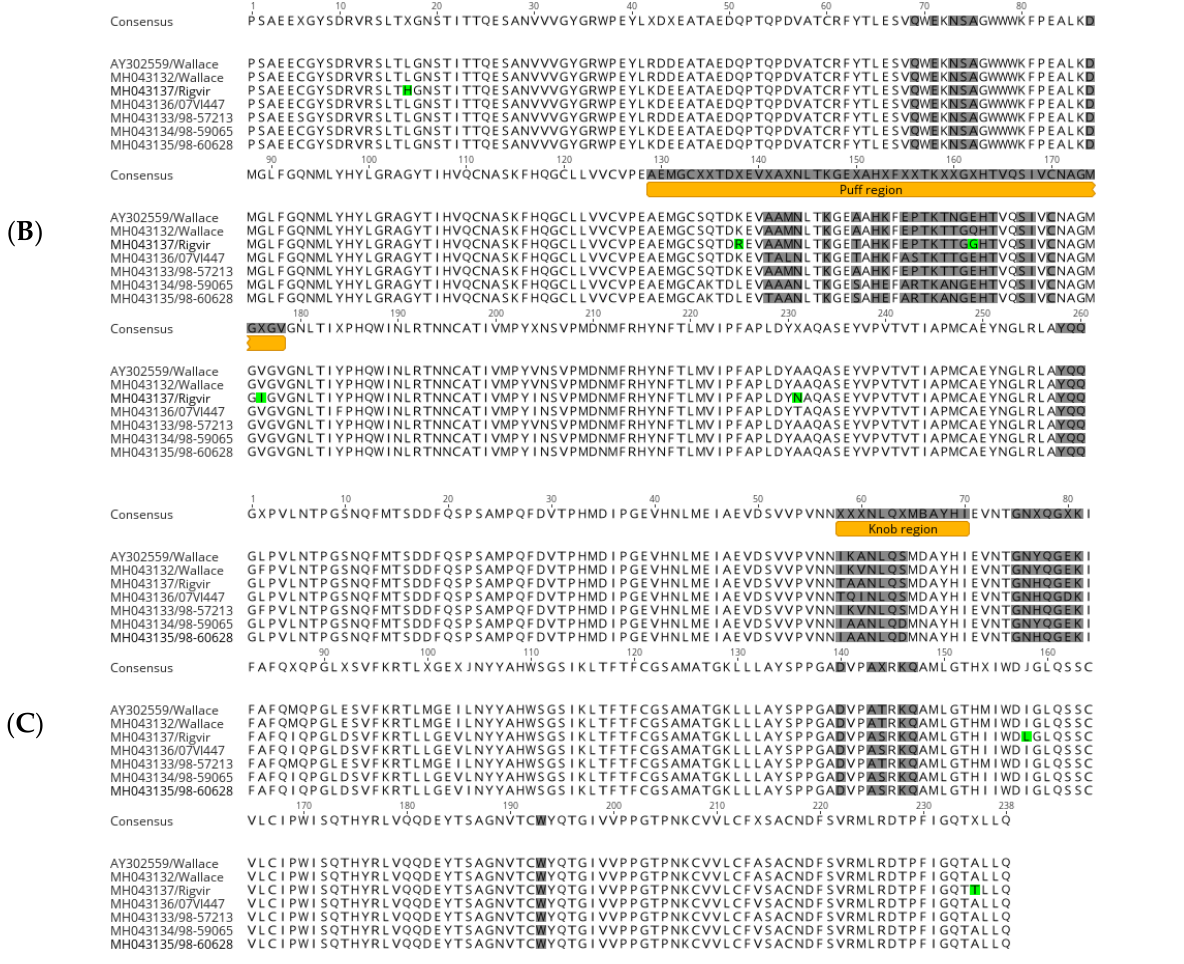
Figure 2. Protein sequence alignment of E7 capsid proteins: ( A ) VP1, ( B ) VP2, and ( C ) VP3. Positions shaded grey are residues that form direct contact with decay-accelerating factor (DAF). Unique mutations found in Rigvir ® are colored green, and the “puff” and “knob” structural motifs that contain the majority of DAF contact residues are colored orange.